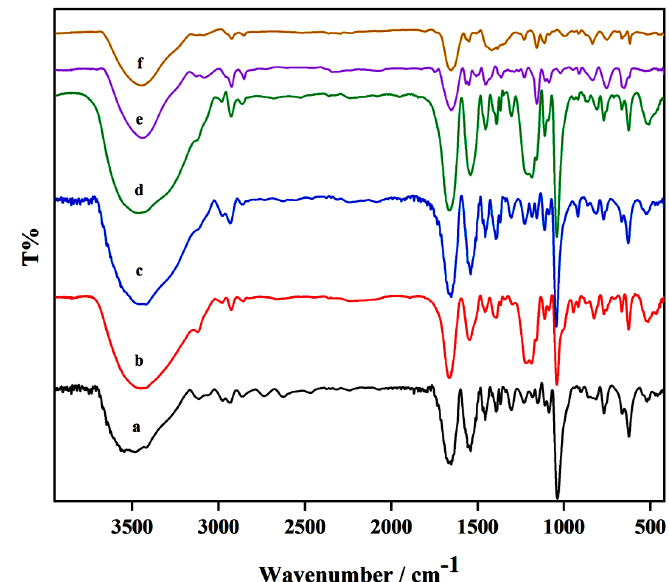
Fig. 2. FT-IR spectra of a) p(AMPS-Na + - co -VIm), b) p(AMPS-Na + - co -VIm)-Ag, c) p(AMPS-H + - co -VIm), d) p(AMPS-H + - co -VIm)-Ag, e) p(AMPS-Na + - co -VIm)-BB, f) p(AMPS-Na + - co -VIm)-BB-Ag.